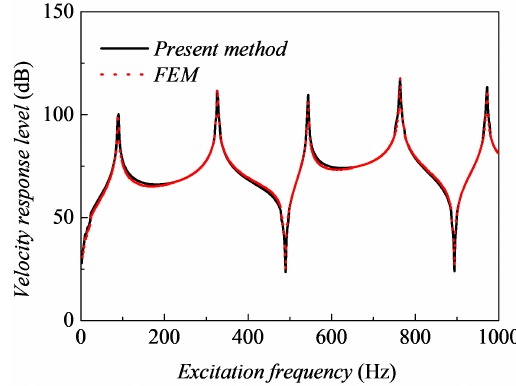
Figure 8: The velocity response of point (0.2,0.3) with